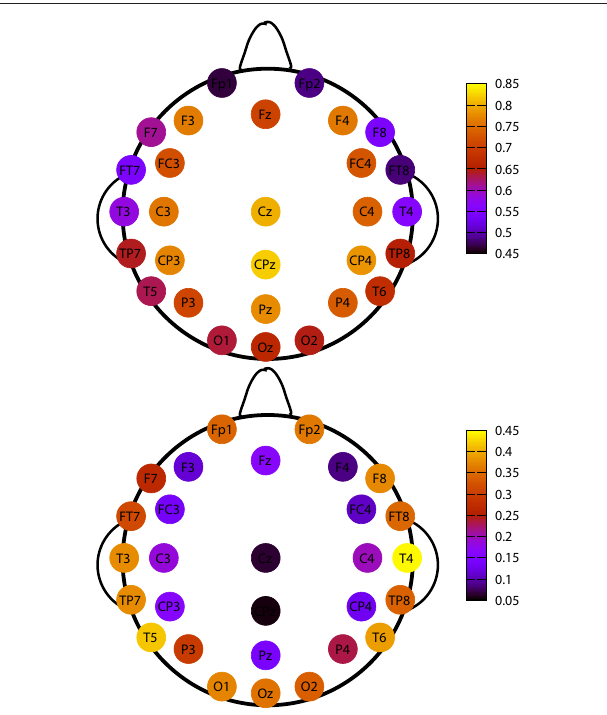
FiGuRE 6 | Top panel: topological plots for average values of δ . Bottom panel: difference between the δ values at the 75th and the 25th percentile of the distribution of the values, for each channel, in our subjects data set.